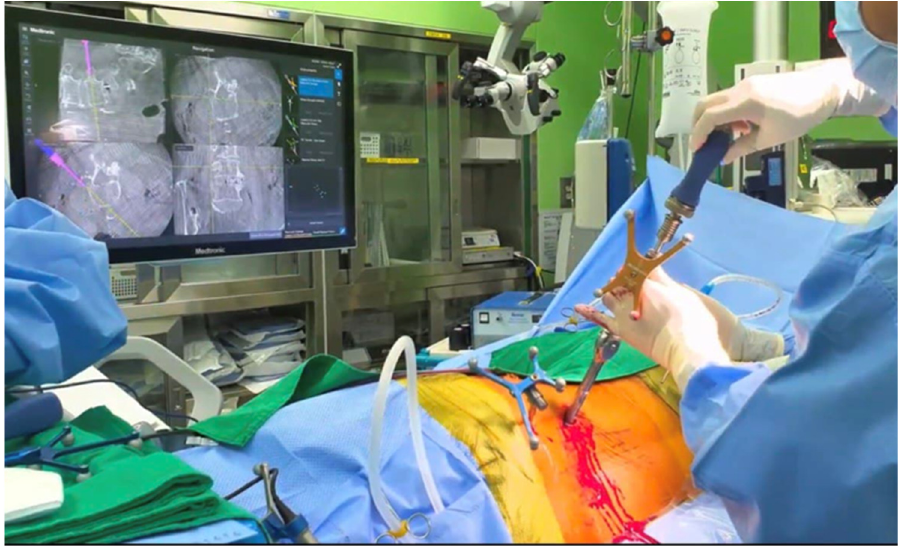
Figure 3. This is a figure. Schemes follow the same formatting. Intraoperative images demonstrating Figure 3. Intraoperative images demonstrating placement of percutaneous pedicle screws under placement of percutaneous pedicle screws under O-arm navigation system. O-arm navigation